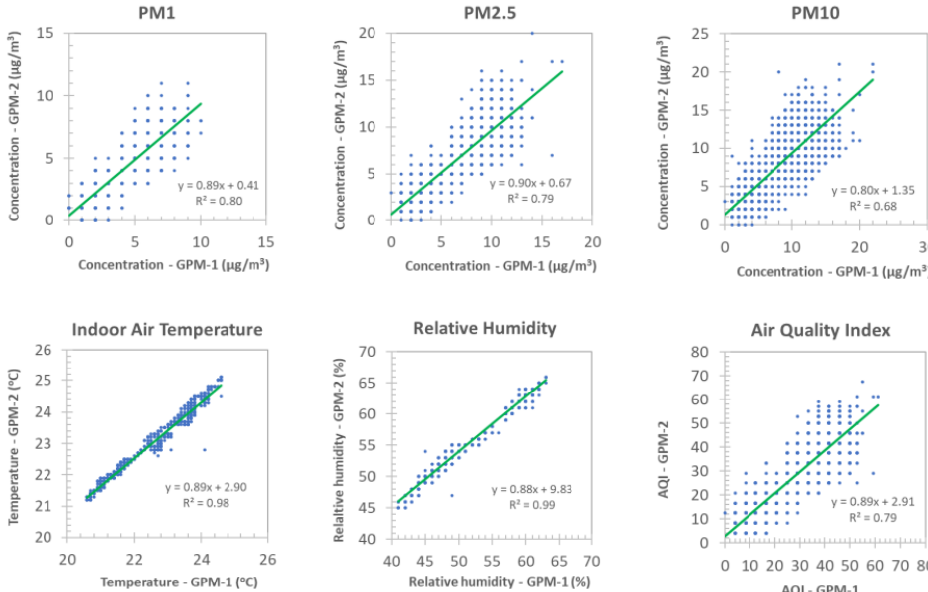
Figure 3. Correlation between the data series of GPM sensors for indoor air monitoring (living room) at the urban site, for 26 May, 2021 (sampling rate: 10 s, n = 4660).